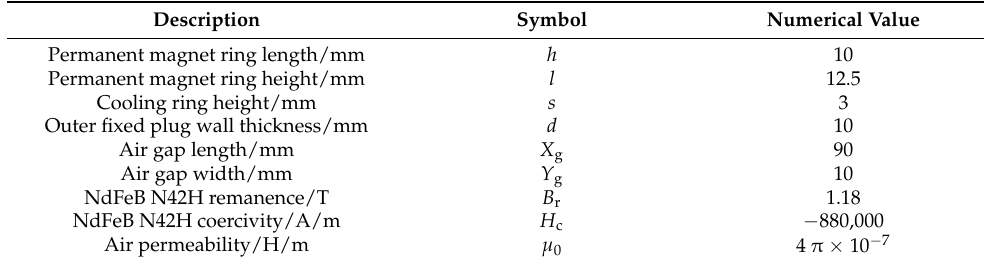
Table 4. Stator parameters of the